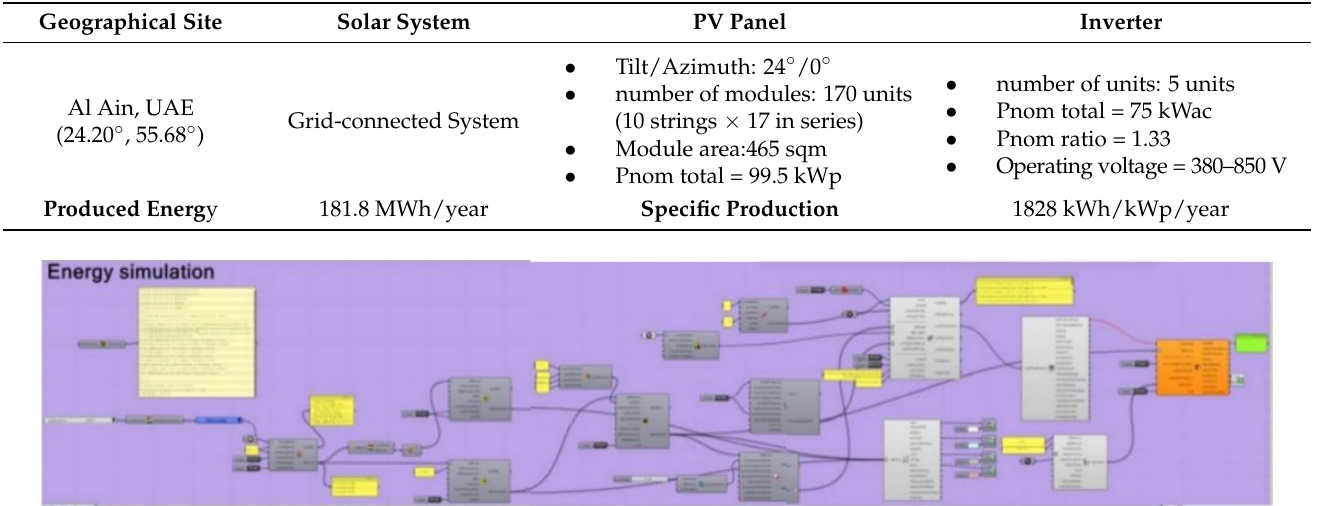
Figure 25. Solar radiation calculation of the roof for PV application. Table 2. Summary of solar energy system.